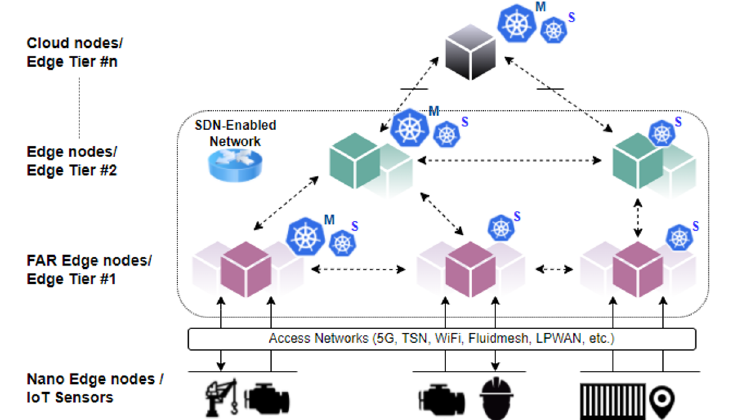
Figure 5. ASSIST-IoT deployment